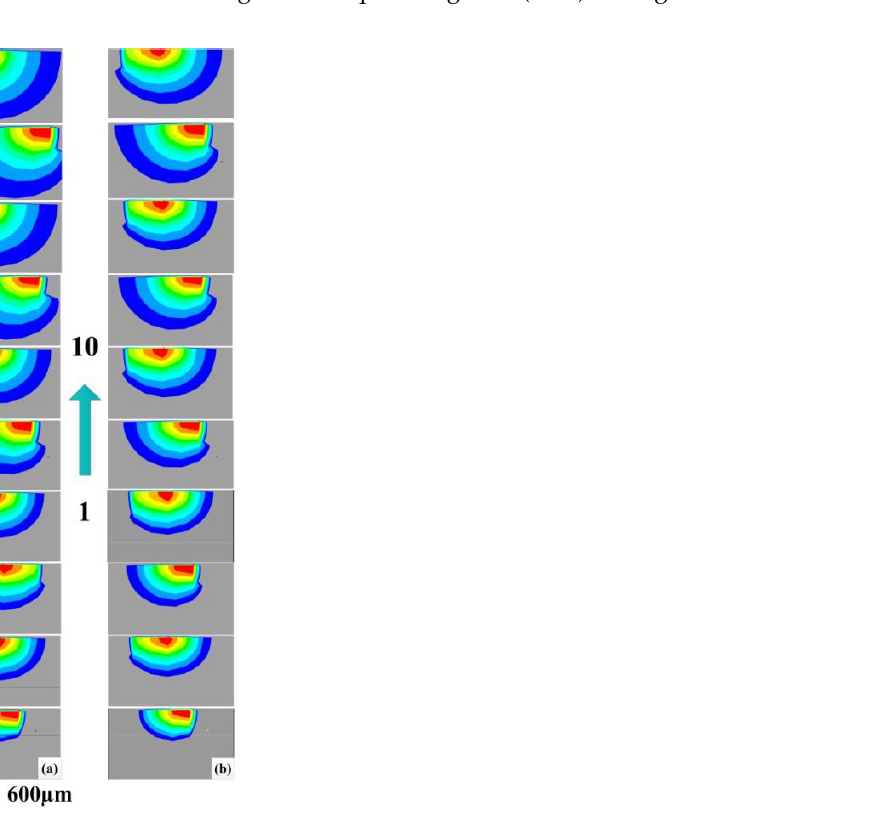
Figure 11. Comparison of multi-layer simulation molten pool with ( a ) constant power and ( b ) layer-by-layer reduced power.